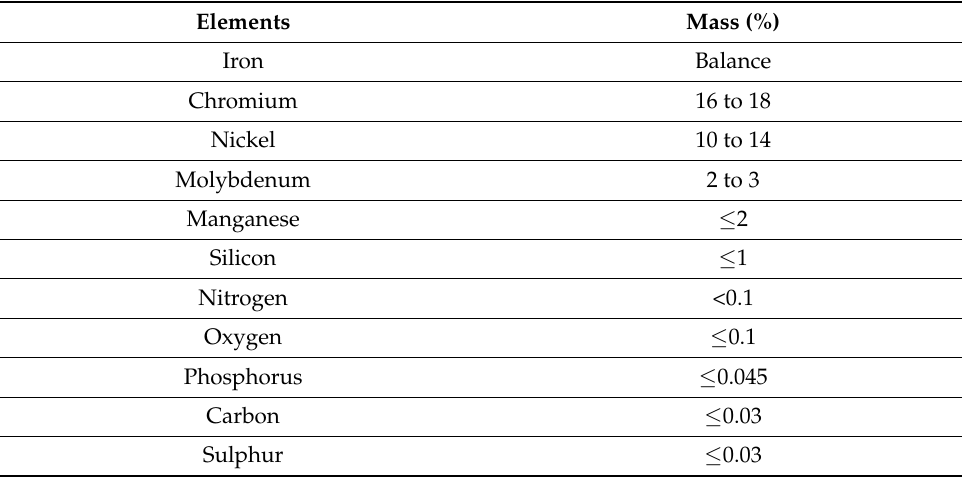
Table 1. Nominal composition of the stainless steel 316L powder used for lattice production.